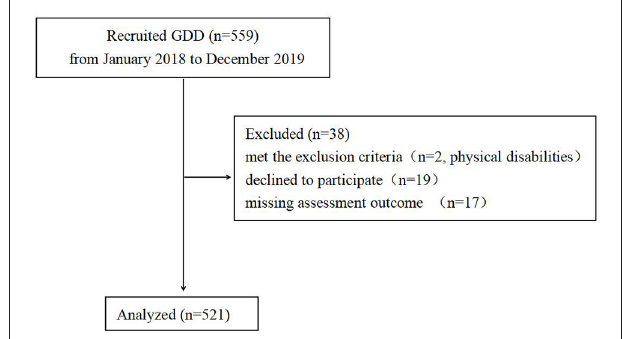
FIGURE 1 | Flow chart of participants